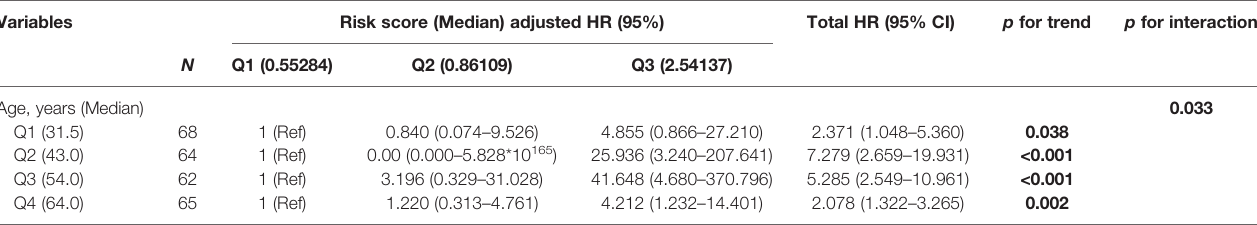
TABLE 2 | Strati fi cation analysis of age and risk score.